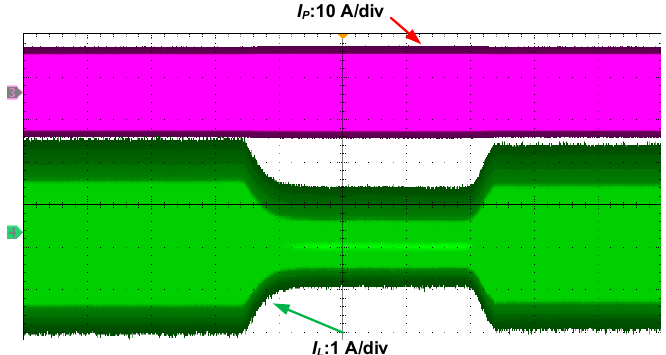
Figure 19. Waveforms of I L and I P when load tripping occurs.